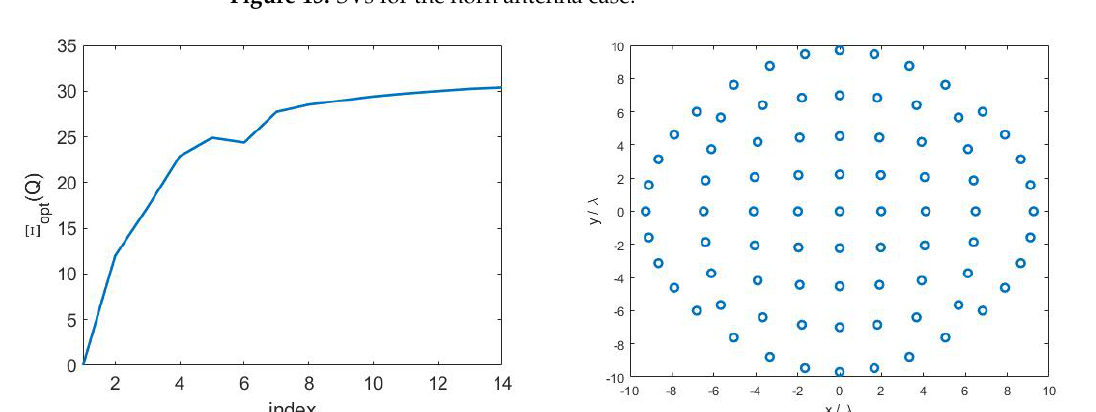
Figure 16. ( Left ): Curve of the optimized SVO functional with varying number of sampling points Ξ opt ( Q ) . ( Right ): SVO sampling points.